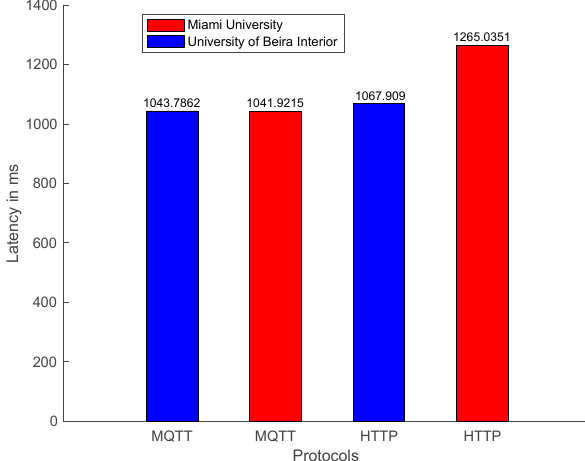
Figure 7. 4diac MQTT and HTTP FBs.